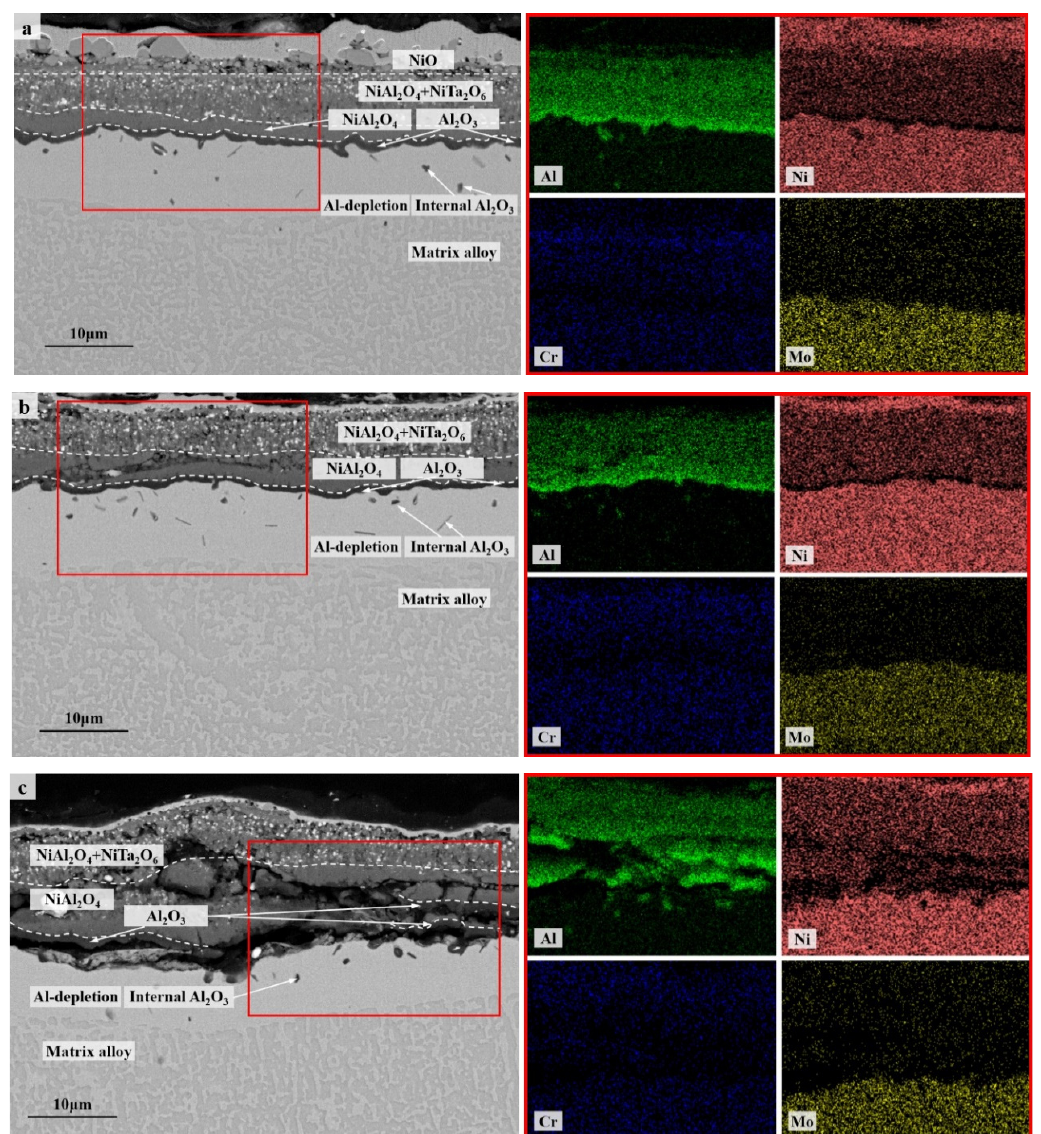
Figure 5. Cross-section morphologies (BSE) and composition distributions (EDS map scanning) of the oxide scales on the specimens of IC21 alloy with different thicknesses after 100 h of cyclic oxidation at 1100 ◦ C: ( a ) S01-N, 0.1 mm; ( b ) S03-N, 0.3 mm; ( c ) S10-N, 1.0 mm. The red square is the area of EDS map scanning.